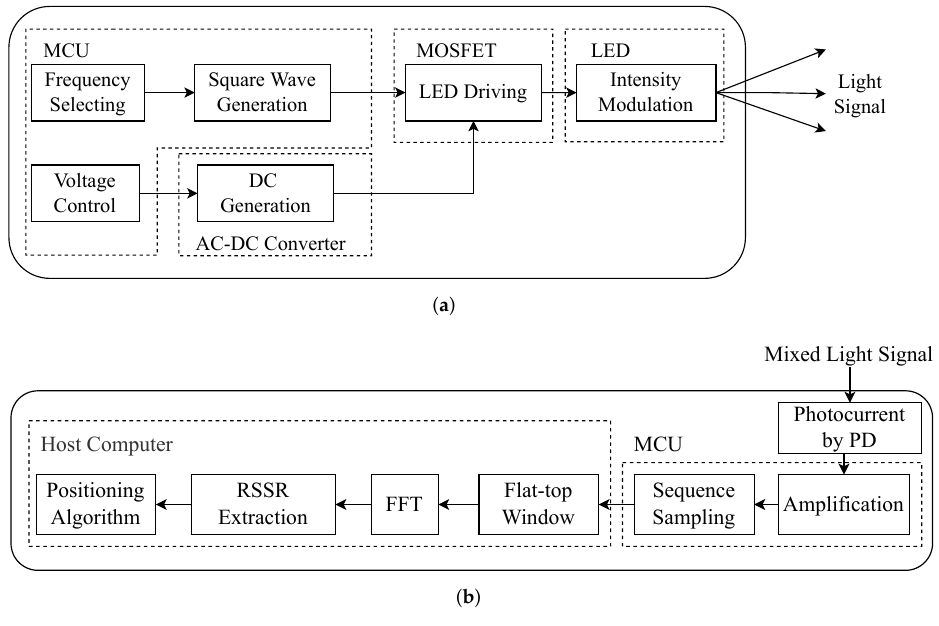
Figure 2. The diagrams of the main parts of the proposed VLP system: ( a ) low-cost MCU-based transmitter, ( b ) PD-based